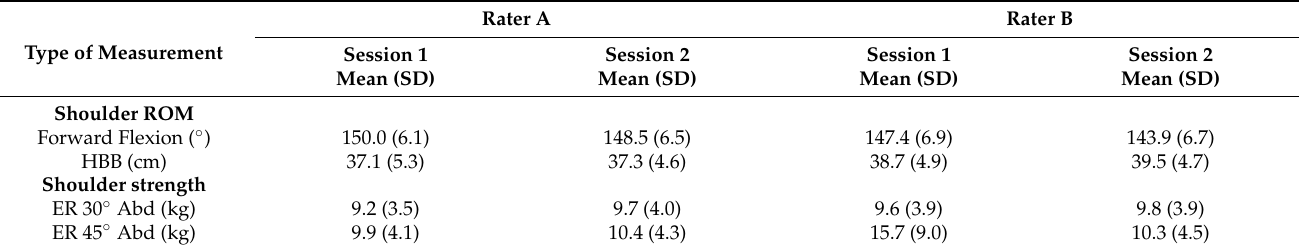
Table 3. Mean and SDs for all measurements and trial sessions (n = 24).